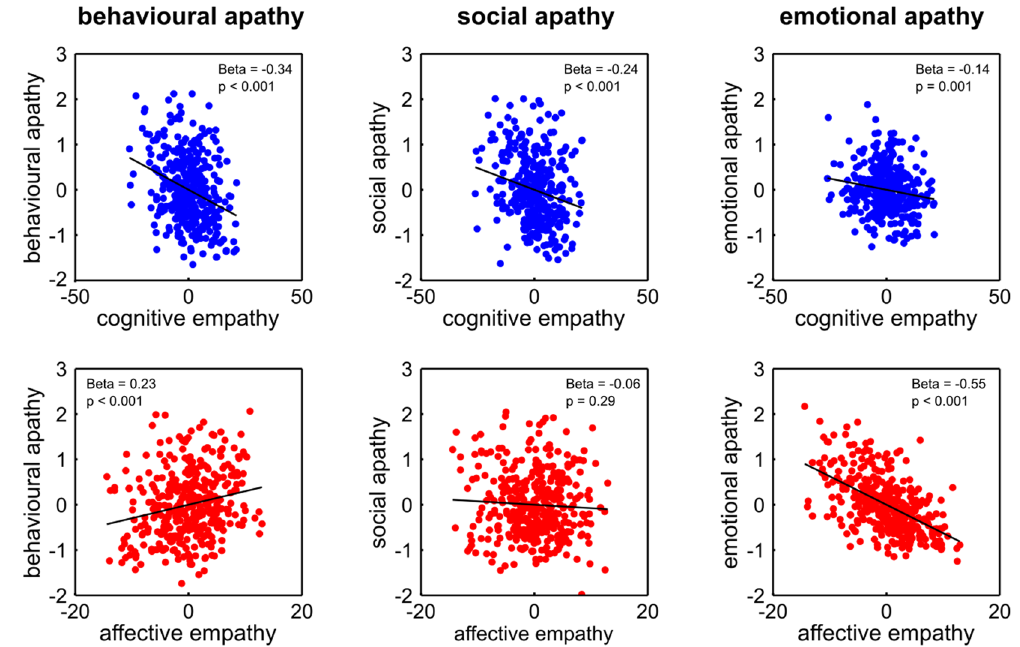
Figure 1. Relationships between different domains of empathy and apathy. Partial correlation plots from multiple regression models showing how unique variance associated with cognitive and affective empathy is associated with different domains of apathy-motivation (behavioural, social and